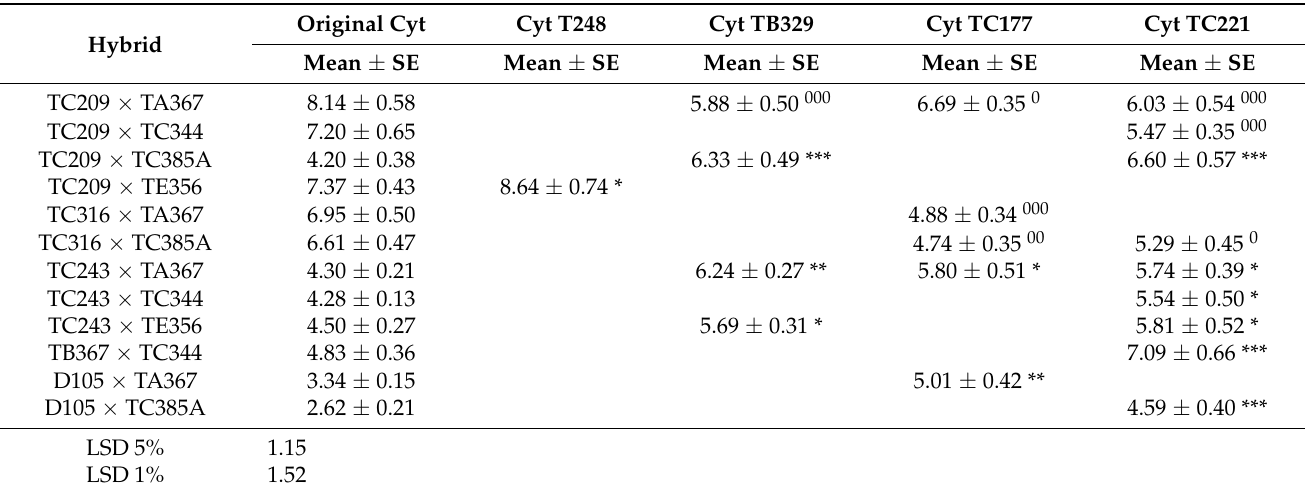
Table 7. The influence of cytoplasm × nucleus × tester interaction on some hybrids’ lutein content ( µ g/g)—ANOVA test.